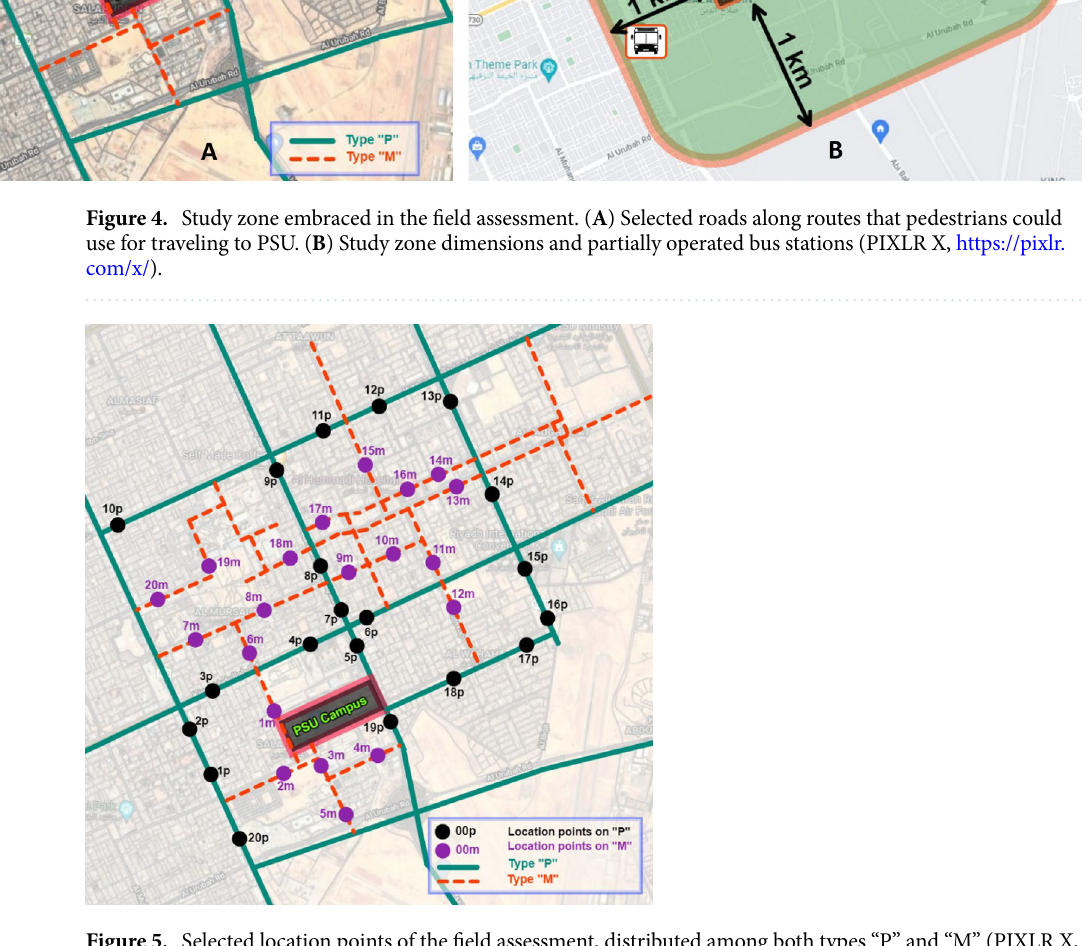
Figure 5. Selected location points of the field assessment, distributed among both types “P” and “M” (PIXLR X, https:// pixlr.